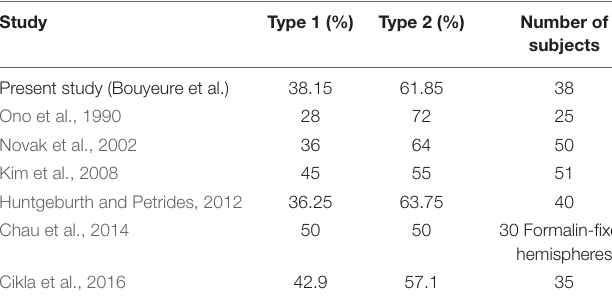
TABLE 4 | Sulcal morphology in children and teenagers compared with